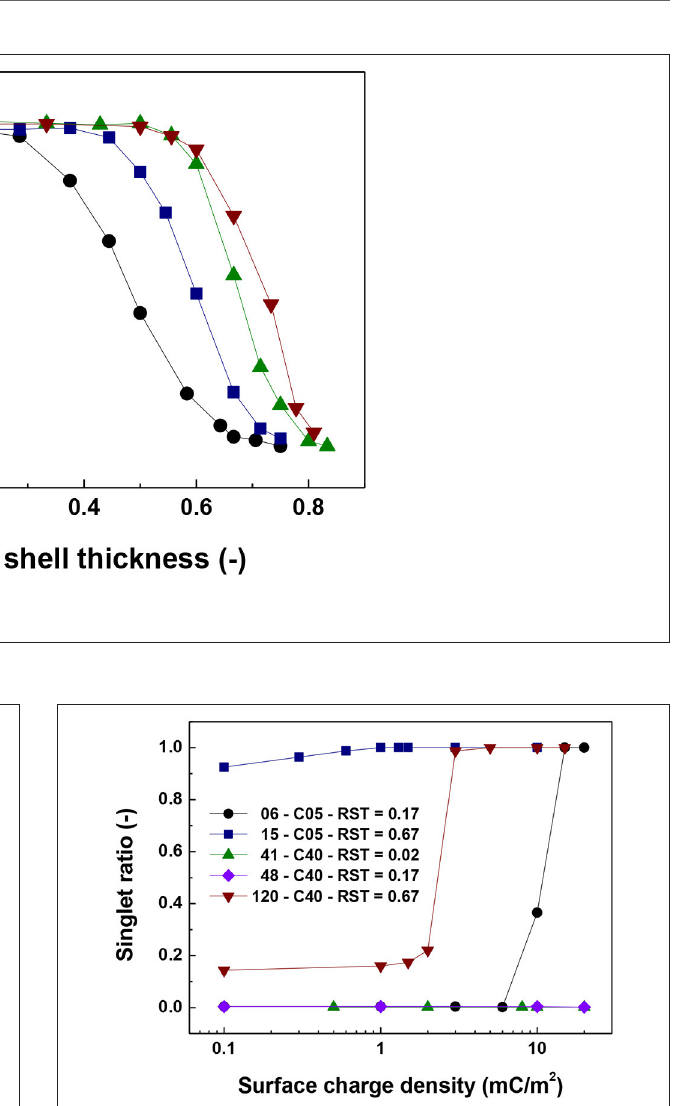
FIGURE 4 | Largest fragment ratio vs. relative shell thickness. FIGURE 5 | Singlet ratio vs. surface charge density. The figure presents the